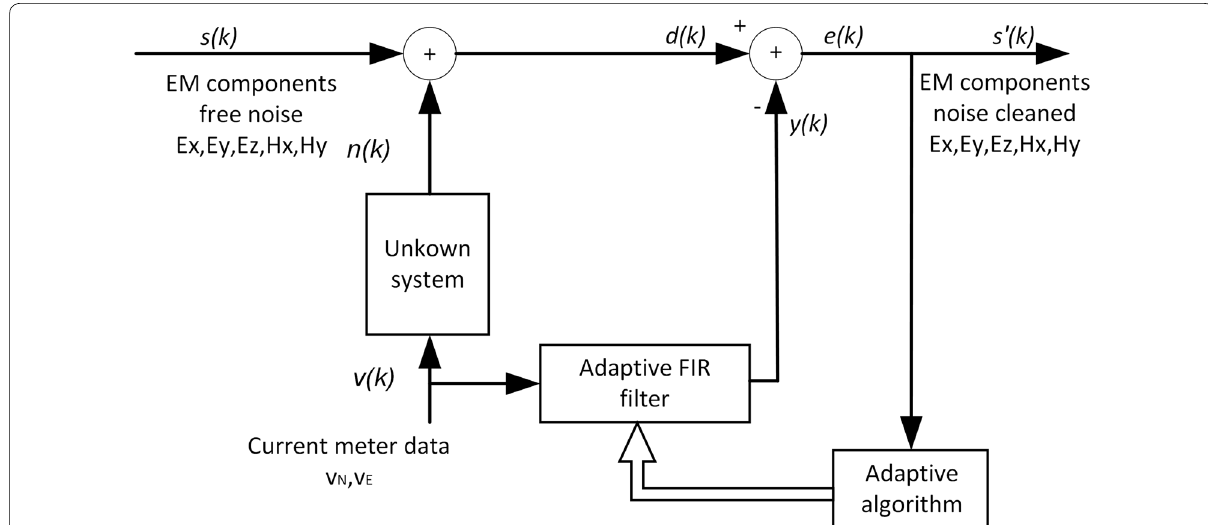
Fig. 7 Diagram of the adaptive correlation cancellation filter developed to cancel seawater motion-induced EM noise. The s(k) represents the EM component free noise, and s ʹ (k) represents the residual uncorrelated output signal, which is the cleaned noise